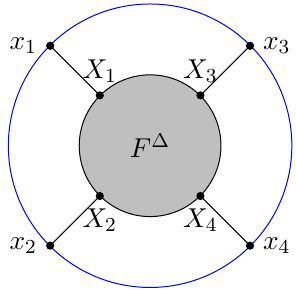
Figure 1 . General four-point Witten